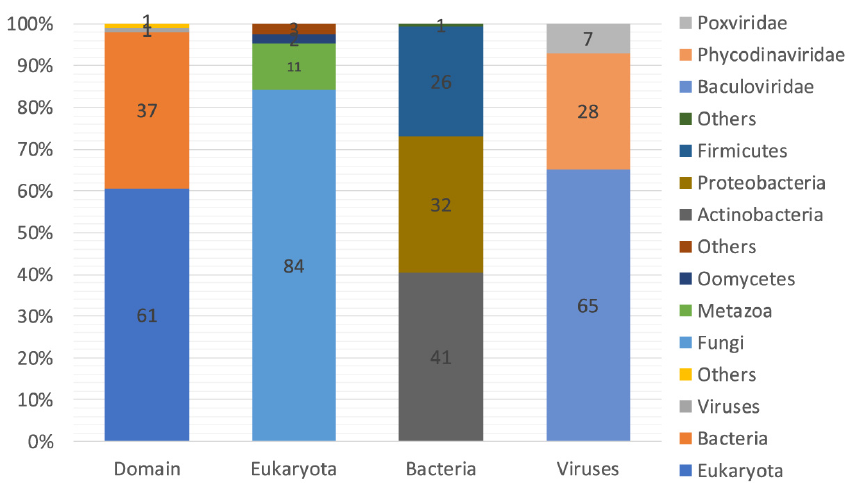
Figure 3. Taxonomic occurrence of LPMO sequences mined. From left to right, the first bar shows the distribution of the sequences according to their Domain, Eukaryota, Bacteria, Viruses, Others, indicated in percentages of total sequences. The following three bars indicate the distribution (in percentages) of sequences as a function of the total number of sequences in the Domain (indicated below the